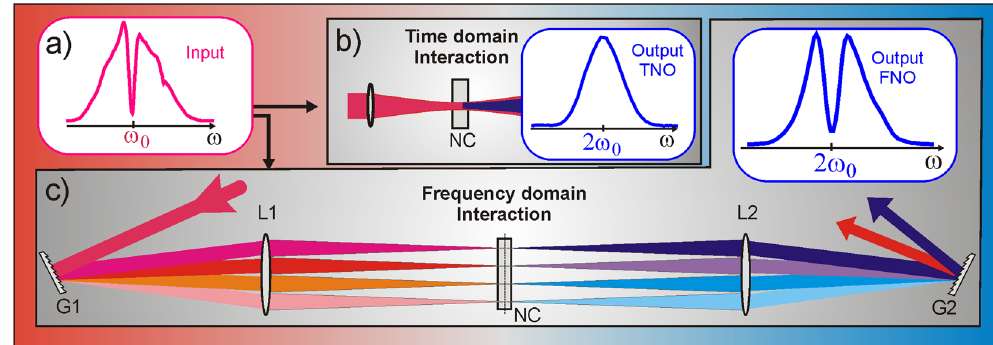
Figure 2. An input spectrum ( a ) is frequency doubled in a nonlinear crystal (NC) via ( b ) Time domain Nonlinear Optics (TNO) and via ( c ) Frequency domain Nonlinear Optics (FNO). ( b ) The experimental SH spectrum obtained by TNO (blue curve) shows a smooth function without the initial central hole. In FNO ( c ), the experimentally obtained SH spectrum at the output of the 4 f setup (blue curve) exhibits the same shape as the input